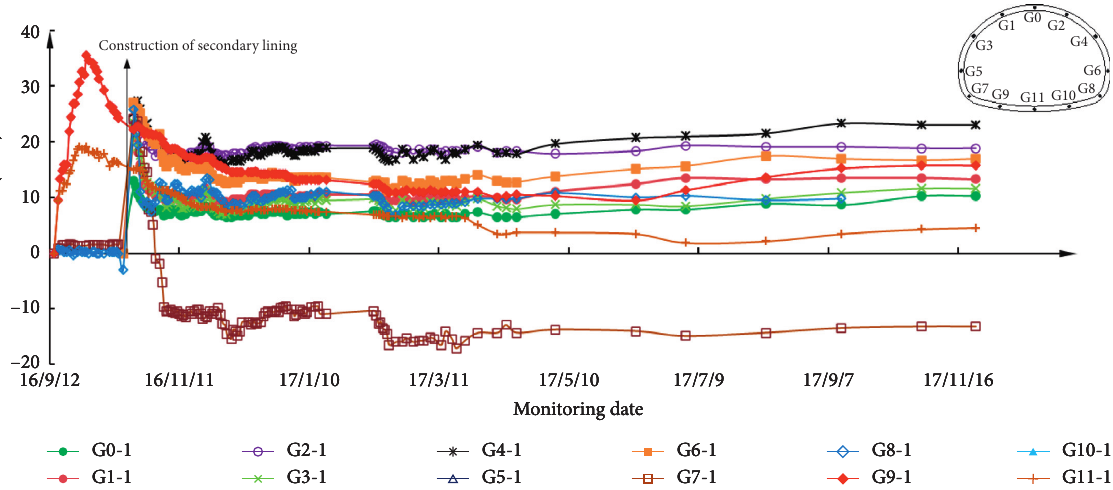
Figure 18: Steel stress (outside) time curve of secondary lining in YK2+133 section.